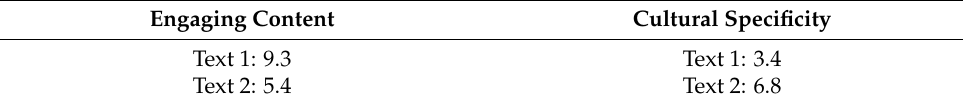
Table 2. Content analysis results based on focus group participant